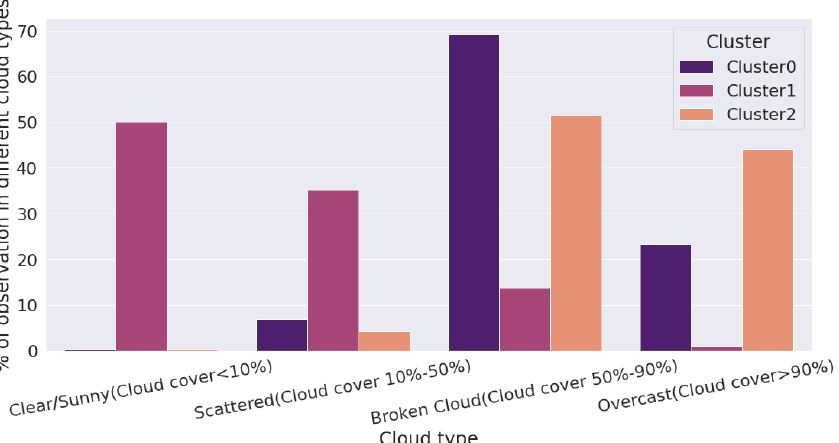
Figure 11. Understanding cloud patterns via cluster-specific distribution of cloud